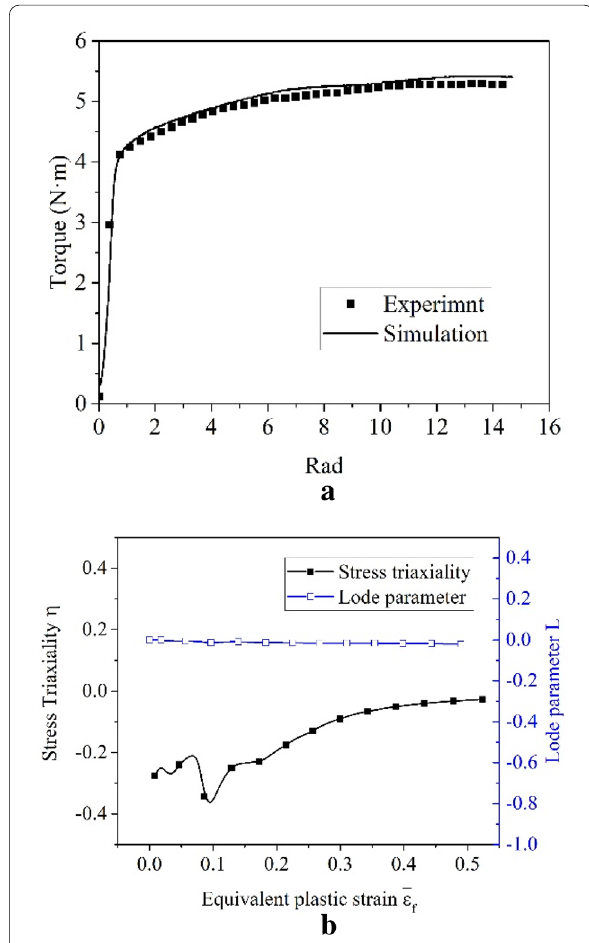
Figure 13 Torsion test: a Torque–twist angle curve obtained from experiments and simulation and ( b ) the evolution of ST and LP with plastic strain